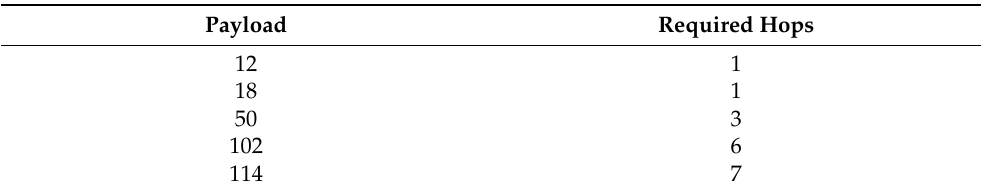
Table 2. Number of hops required to balance out a retransmission with iACK compared to eACK according to the payload size.